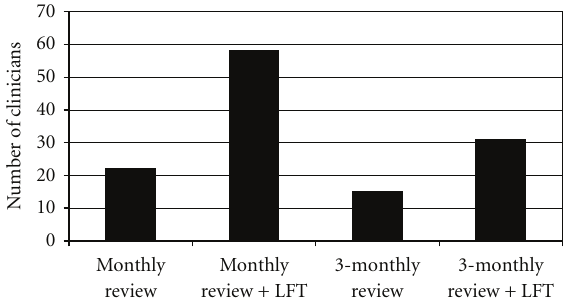
Figure 1: Followup during